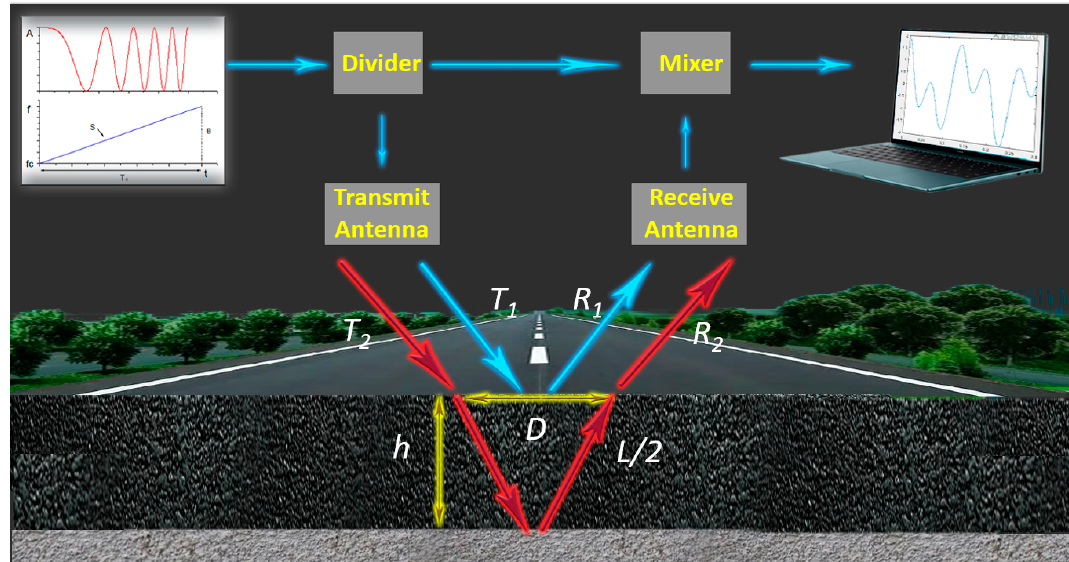
Figure 1. FMCW radar measurement principle.